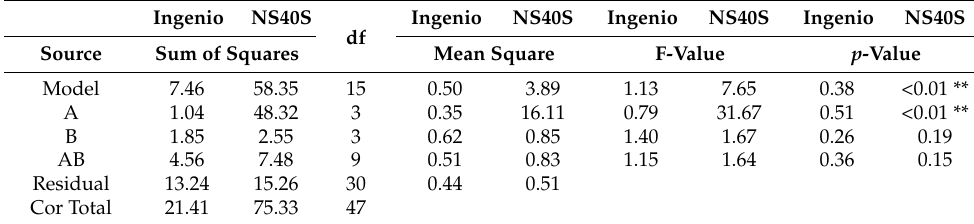
Table 7. ANOVA table for grain yield in 2019.